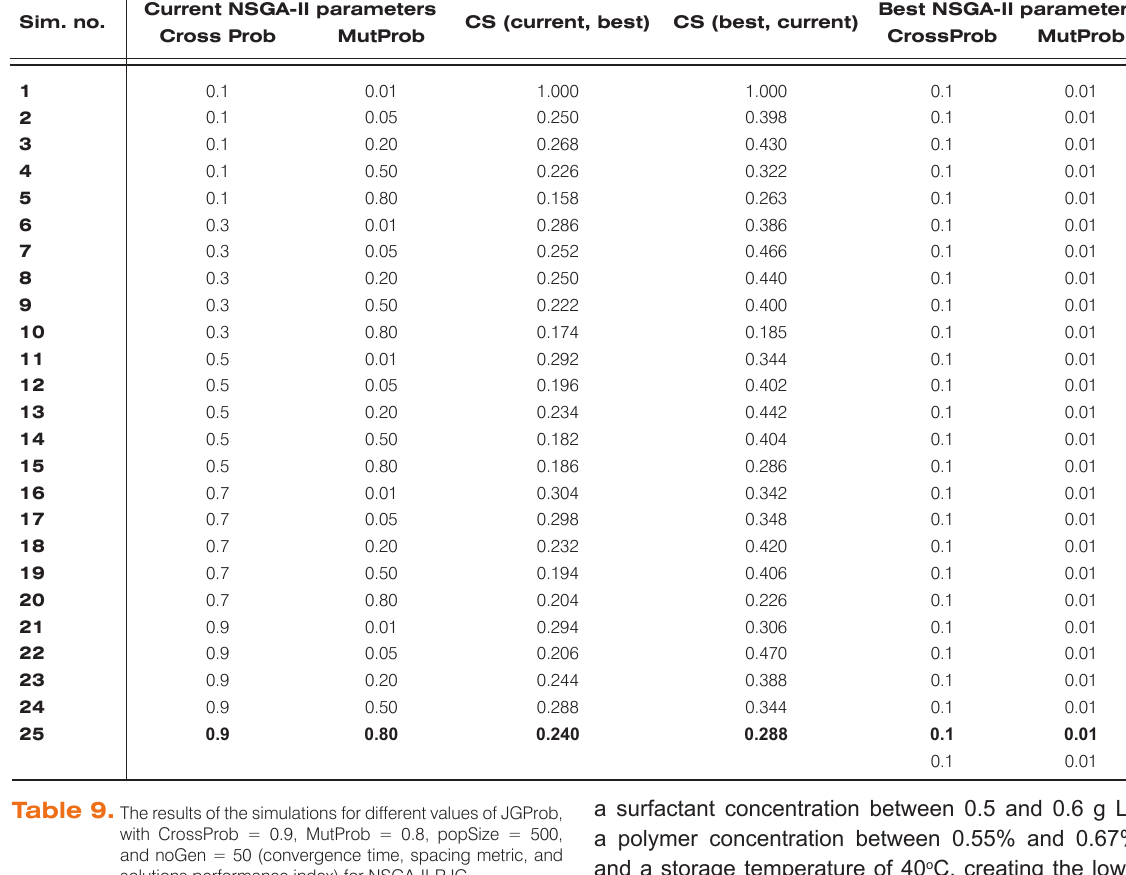
Table 8. The results of the simulations for different values of CrossProb and MutProb with popSize = 500 and noGen = 50 (set coverage metric) for NSGA-II. Sim.